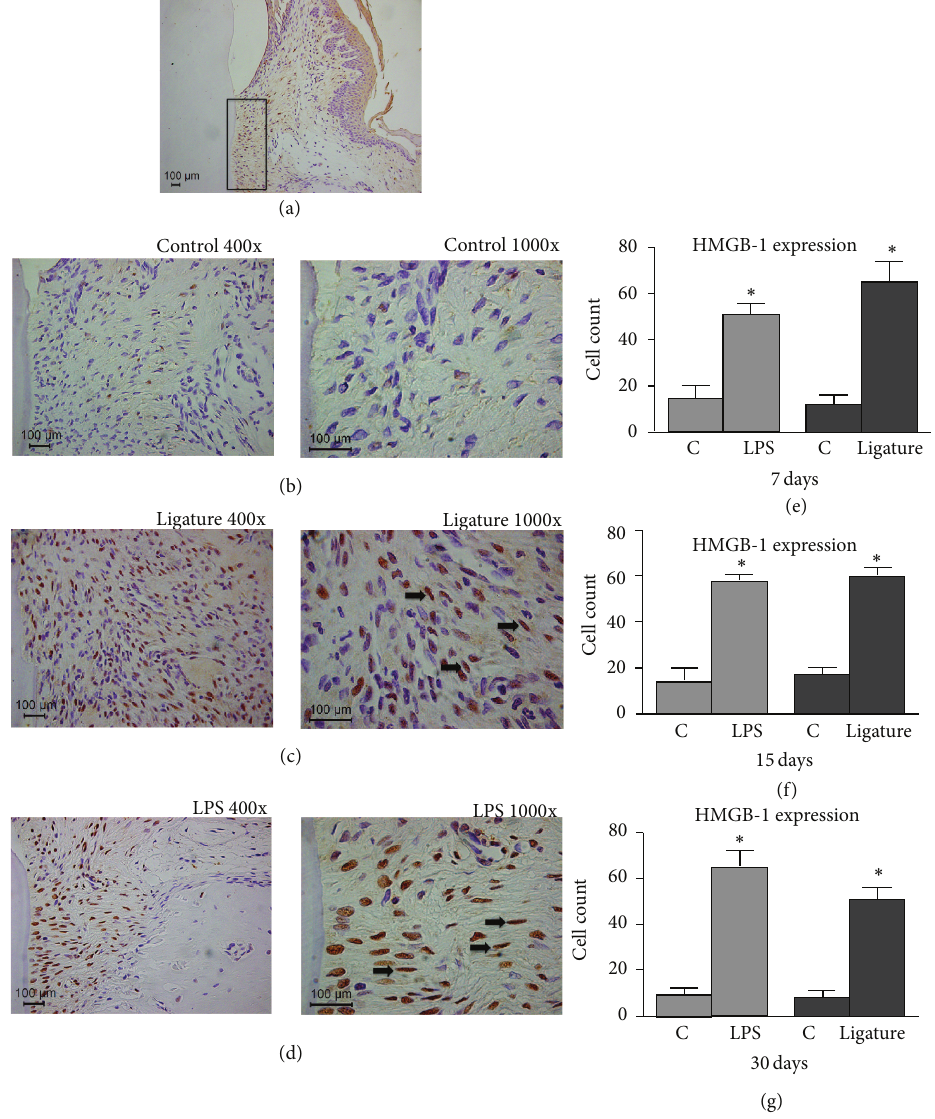
Figure3:Immunohistochemicalanalysisoftheinflammatoryprocess.(a)Representativelowermagnificationoftheimages(b)to(d)showing the selected region in the interproximal area of the first maxillary and mandibular molars. (b) Images of the control group showing few stained cells at 7 days. (c) and (d) Images of the ligature and LPS groups, respectively, showing many stained cells at 7 days. (e) to (g) Graphs with mean ± standard deviation of the number of positive cells to HMGB1 at 7, 15, and 30 days. ∗ Significant differences compared to control ( 𝑃 < 0.05